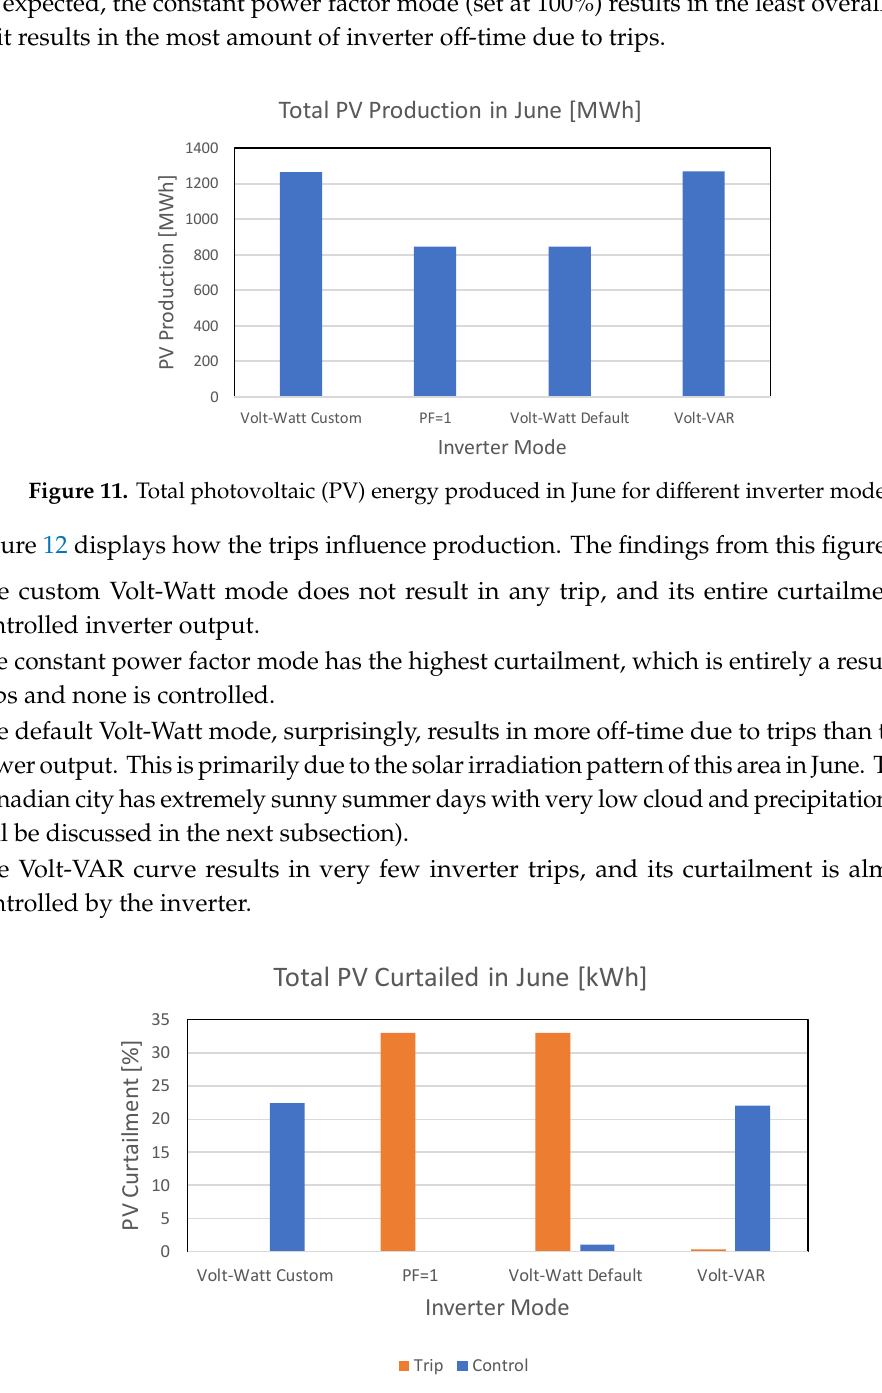
Figure 12. Total PV curtailed in June due to inverter trips and control.